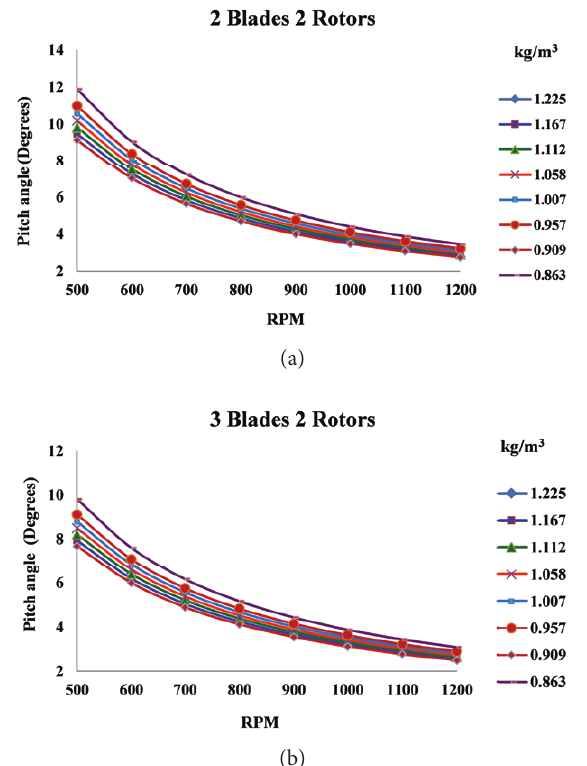
Figure 2. Θ – n relation for 2-blade 2 rotor and 3-blade 2 rotor coaxial rotor systems